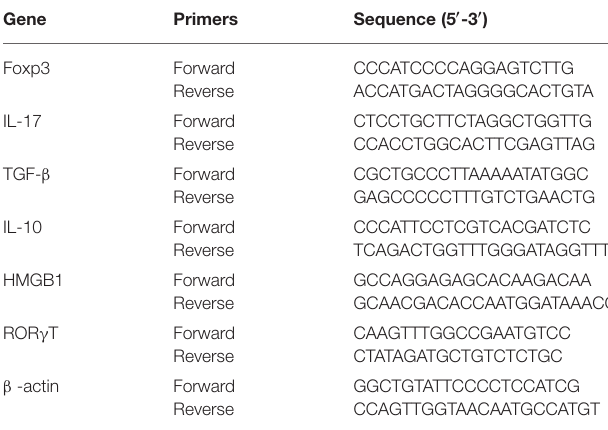
TABLE 1 | Primer sequences for